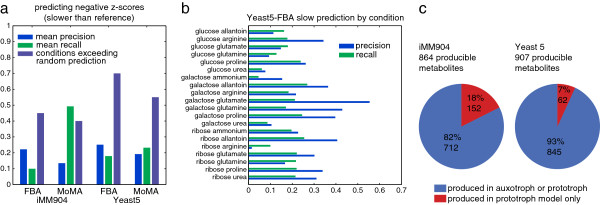
Agreement between constraint-based modeling predictions and experimental observations. (a) Assessment of constraint based modeling predictions for slow growth. Precision and recall (blue and green) were calculated for each model in each of 20 conditions (glycerol:* and glucose:ammonium excluded; Additional file 6) and means are shown here. The fraction of conditions in which predicted model mutants overlap significantly with significant z-score effects is shown in purple. (b) Precision and recall scores (as in (a)) for each individual condition using the Yeast5 model and standard FBA. (c) Number of producible metabolites for iMM905 and Yeast5 metabolic models. For each model the total number of producible metabolites was counted based on simulation in glucose:ammonium (see Materials and methods). The procedure was repeated for a model in which reactions involving auxotrophic marker genes (HIS3, URA3, LEU2, and MET15) were disabled. The chart shows the proportion of metabolites that the auxotrophic model fails to produce in red.